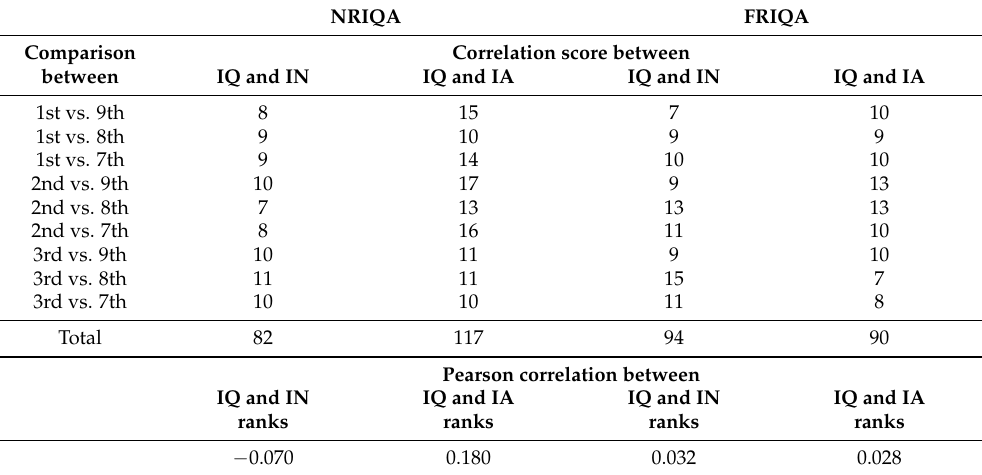
Table 3. Correlations between IQ and IA and IN in the two cases FRIQA and NRIQA. NRIQA FRIQA Comparison Correlation score between between IQ and IN IQ and IA IQ and IN IQ and